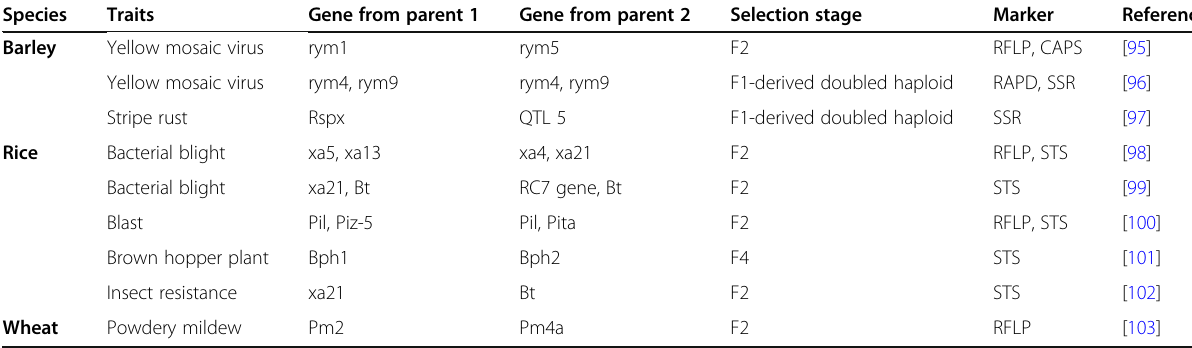
Table 4 The gene or QTL pyramiding in different crops Species Traits Gene from parent 1 Gene from parent 2 Selection stage Marker Barley Yellow mosaic